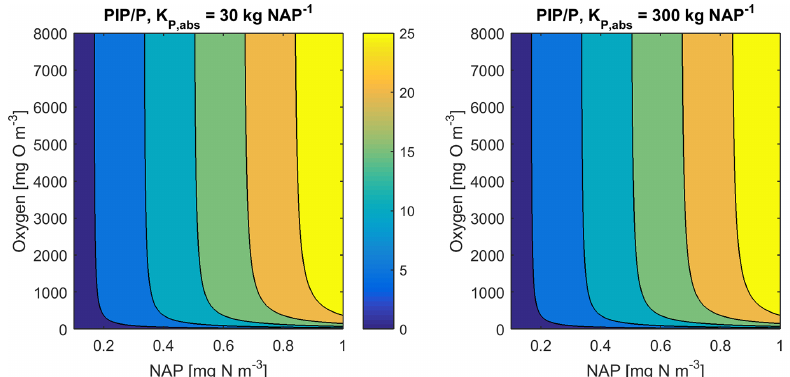
= 74mgOm − 3 at two values of K 2 , abs